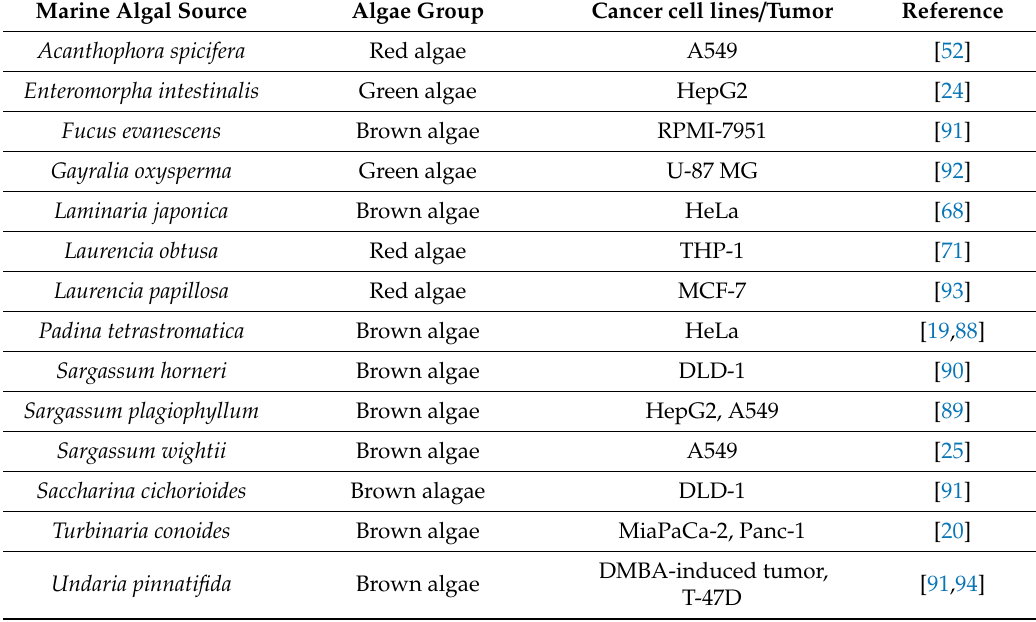
Table 8. Marine algae source with anticancer activity attributed to SPs against cancer cell lines and